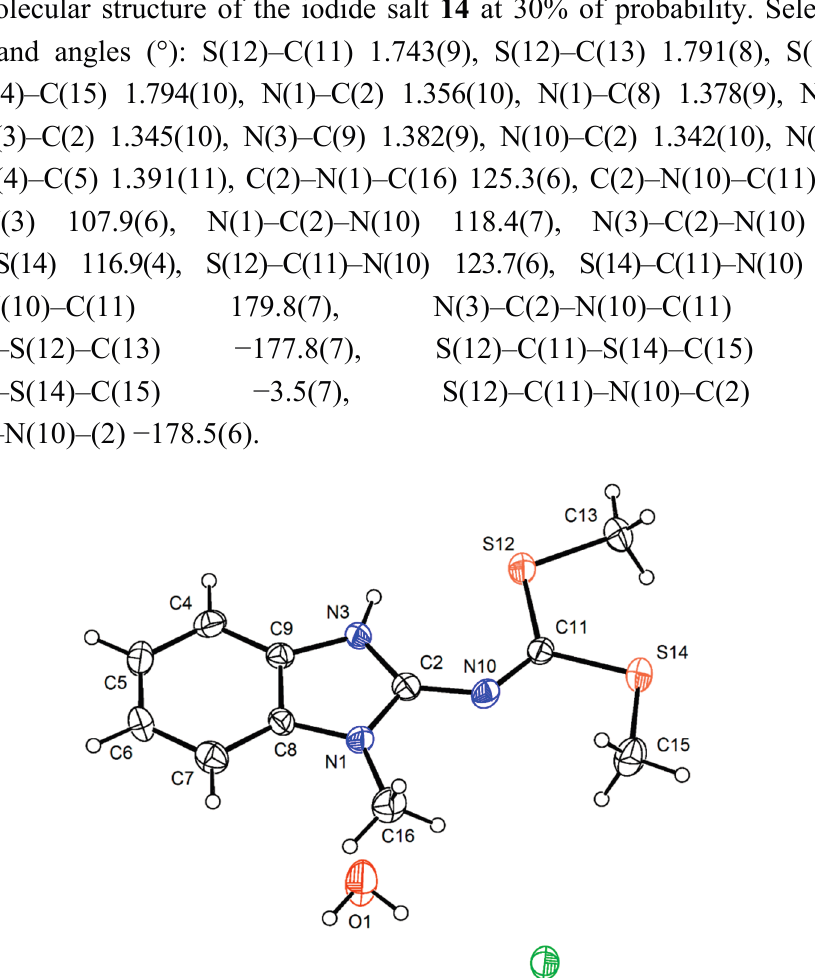
Figure 6. Molecular structure of the iodide salt 14 at 30% of probability. Selected bond lengths (Å) and angles (°): S(12)–C(11) 1.743(9), S(12)–C(13) 1.791(8),